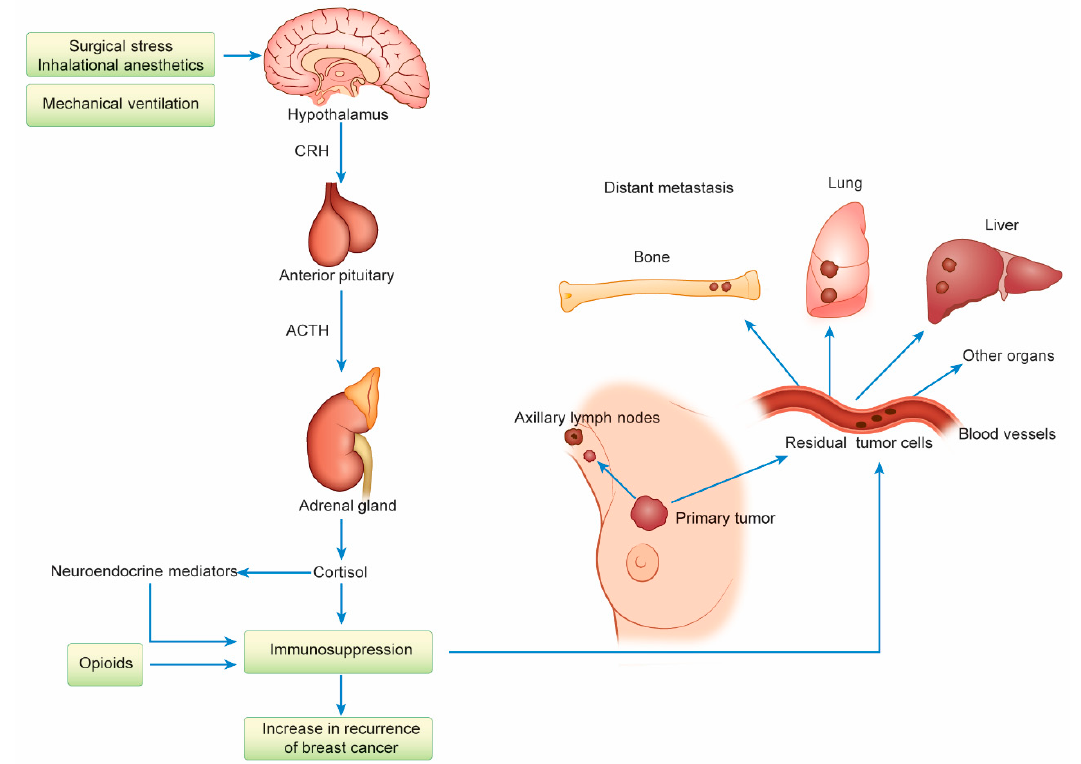
Figure 4. The activation of the hypothalamic-pituitary-adrenal (HPA) axis due to surgical stress and the use of certain anesthetic techniques may be involved in the increased distant recurrence of breast cancer. Surgical stress and general anesthesia (GA) under mechanical ventilation with tracheal intubation activate the HPA axis and increase neuroendocrine mediators, such as cortisol, leading to immunosuppression that increases the distant metastasis of breast cancer. Opioid- induced immunosuppression is also involved in the increase in distant recurrence. The development of distant metastasis to the bone, lung, liver, and other parts of the body from residual tumor cells is observed after surgical treatment. CRH, corticotropin-releasing hormone; ACTH, adrenocorticotropic hormone.